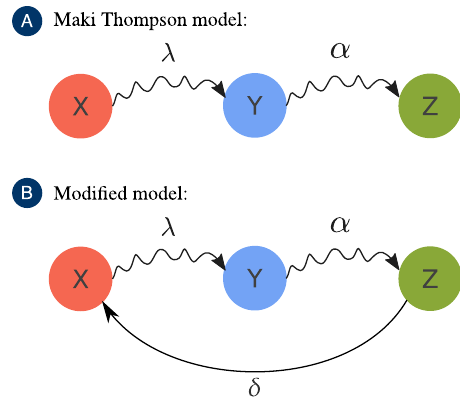
Fig. 1 Graphical representation of the Maki Thompson and our modi fi ed model for each node. In this fi gure, the curly arrows represent transitions driven by contact, while the normal arrow represents a spontaneous transition. To simplify the notation, the states of the nodes are represented in the center of the circles, which show the only Bernoulli random variable that is equal